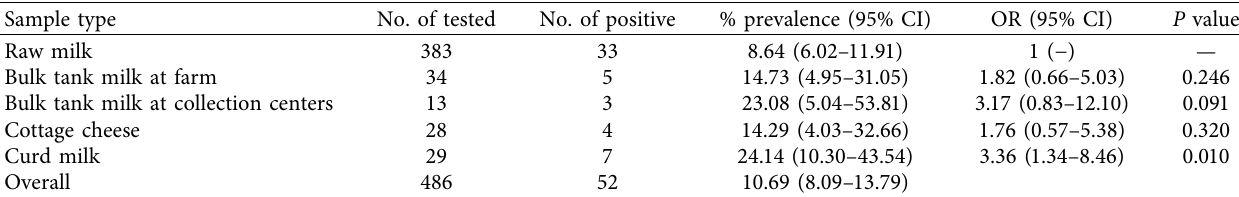
Table 1: Univariable logistic regression analysis of S. aureus prevalence in different sample types.